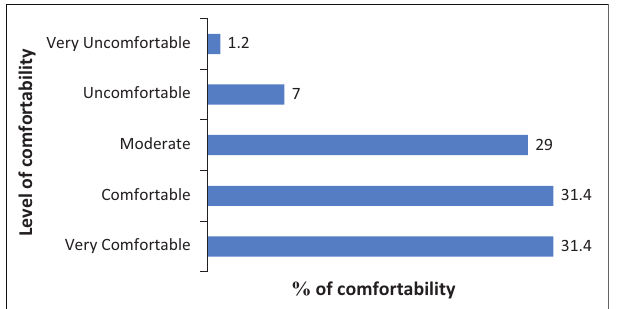
FIGURE 3: Per cent of